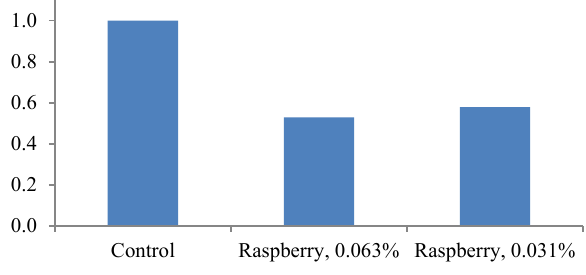
Figure 3 Effect of the raspberry extract on COX-2 expression. The quantitative PCR analysis of COX-2 expression was performed after HCT-116 cells had been incubated for 24 h at working concentrations (0.063% and 0.031%). The number of PCR products was assessed and normalised according to the amount of the PCR product of the Rpl27 gene